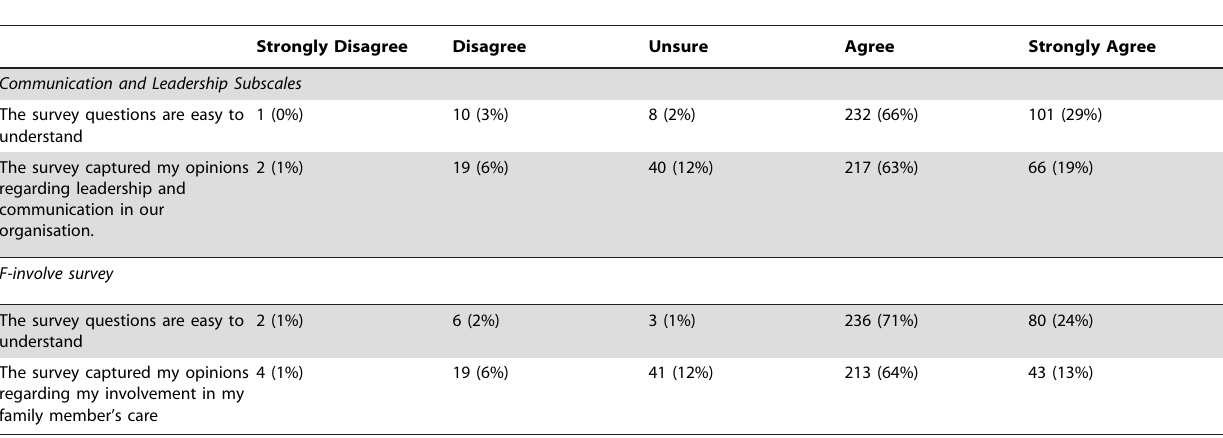
Table 3. Feedback on survey